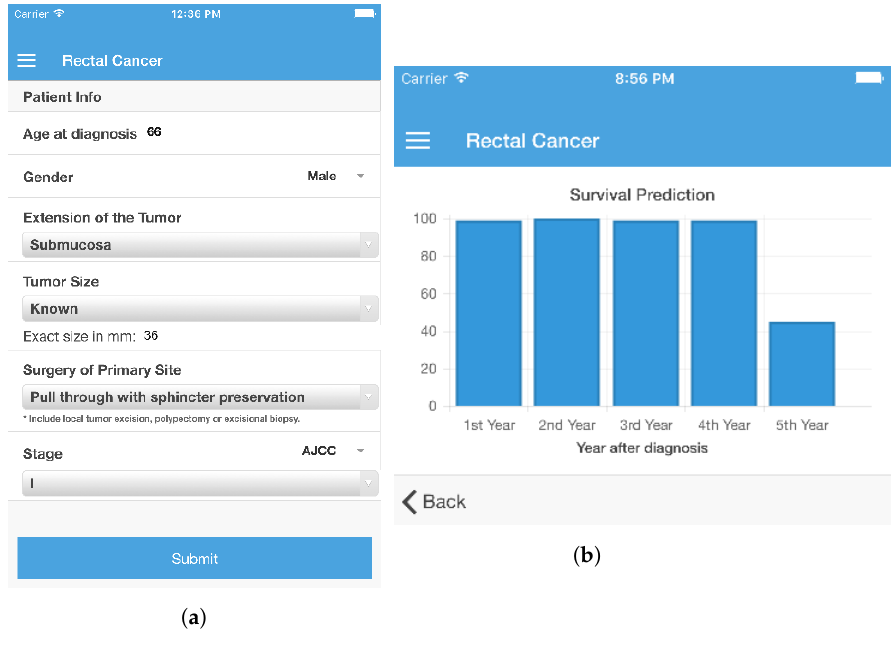
Figure 3. Rectal cancer survivability calculator (smartphone view). ( a ) Survivability Features of Rectal Cancer; ( b ) Results for Rectal